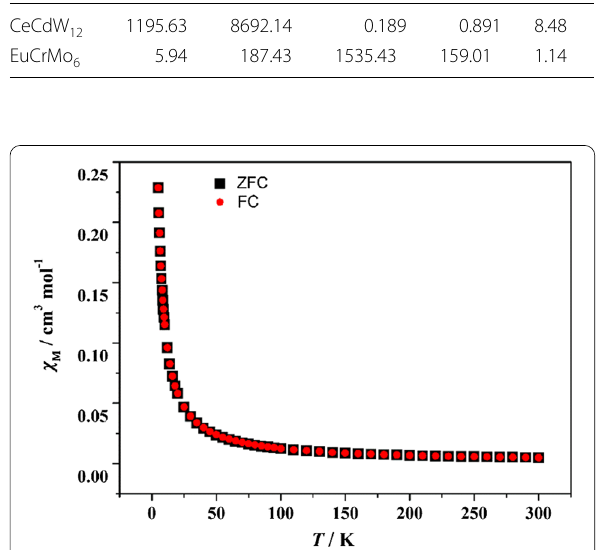
Fig. 16 Temperature dependence of the ZFC and FC magnetization curves for